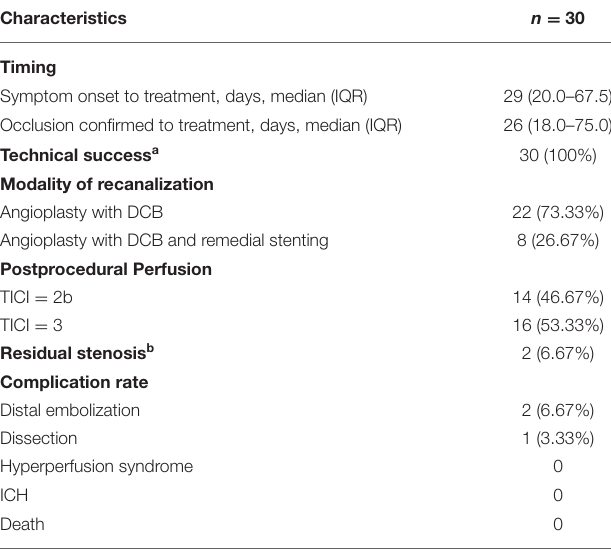
TABLE 2 | Angiographic and procedural characteristics. Characteristics